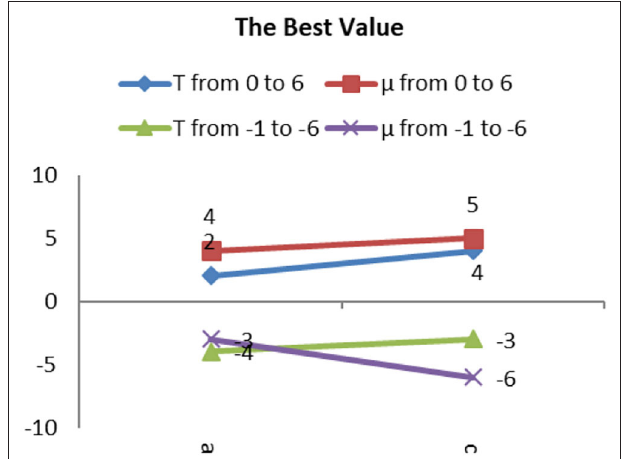
FIGURE 15 | Best values for the two images of group